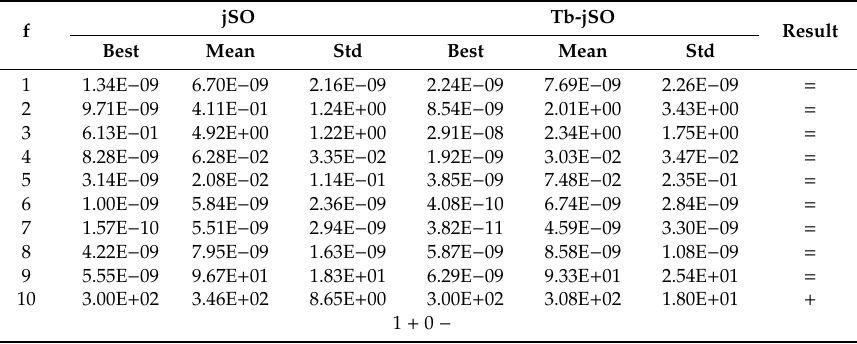
Table 15. jSO vs. Tb-jSO on CEC2020 in 5 D .